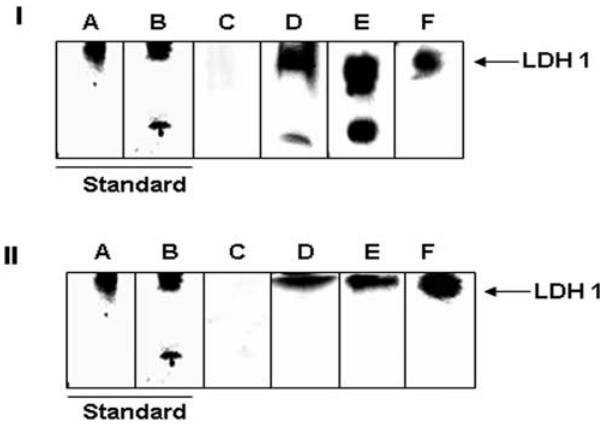
Figure 7. BN PAGE analyses of LDH in an astrocytic cell line. I) Mitochondrial fraction. II) Soluble fraction. A) Coomassie stain for LDH from porcine heart (Sigma). B) Coomassie stain for LDH from porcine muscle (Sigma). C) In gel detection of LDH activity with 0 mM NAD + . D) In gel detection of LDH activity with 0.1 mM NAD + . E) In gel detection of LDH activity with 0.5 mM NAD + . F) In gel detection of LDH activity with 0.5 mM NAD + and 2 mM AgNO 3 .